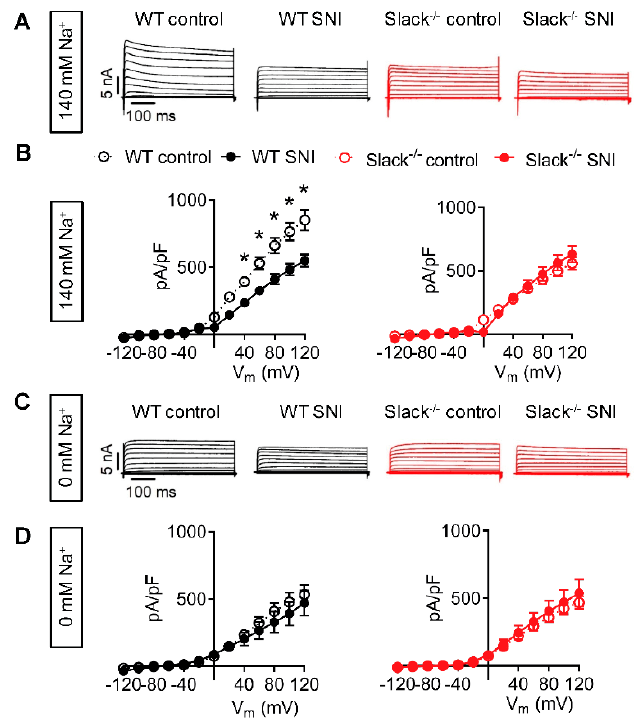
Figure 2. Slack-mediated potassium currents in sensory neurons are reduced after SNI. ( A , B ) Rep- resentative outward K + current (I K ) traces ( A ) and associated current-voltage (I-V) curves ( B ) from whole-cell voltage recordings on IB4-positive lumbar (L4-L5) dorsal root ganglion (DRG) neurons of WT (black) and Slack -/- mice (red) 14–19 days after spared nerve injury (SNI). Contralateral DRG neurons were used as control. Recordings shown in ( A ) and ( B ) were performed in the presence of 140 mM NaCl in the external solution, i.e., under physiological conditions. n = 21–29 cells per group. Repeated ANOVA measures followed by Fisher’s Least Significant Difference test; WT control versus WT SNI: p = 0.0062; Slack -/- control versus Slack -/- SNI: p = 0.4374. ( C , D ) Representative I K traces ( C ) and associated I-V curves ( D ) in the same experimental setting as shown in ( A ) and ( B ), however, after replacement of NaCl by 140 mM choline chloride in the external solution to obtain Na + -free conditions. n = 7–9 cells per group. Repeated ANOVA measures: WT control versus WT SNI: p = 0.1825; Slack -/- control versus Slack -/- SNI: p = 0.6125. The data show that Na + -activated I K (I KNa ) in sensory neurons is carried by Slack channels and reduced after SNI. Data in ( B ) and ( D ) are mean ± SEM. * p <